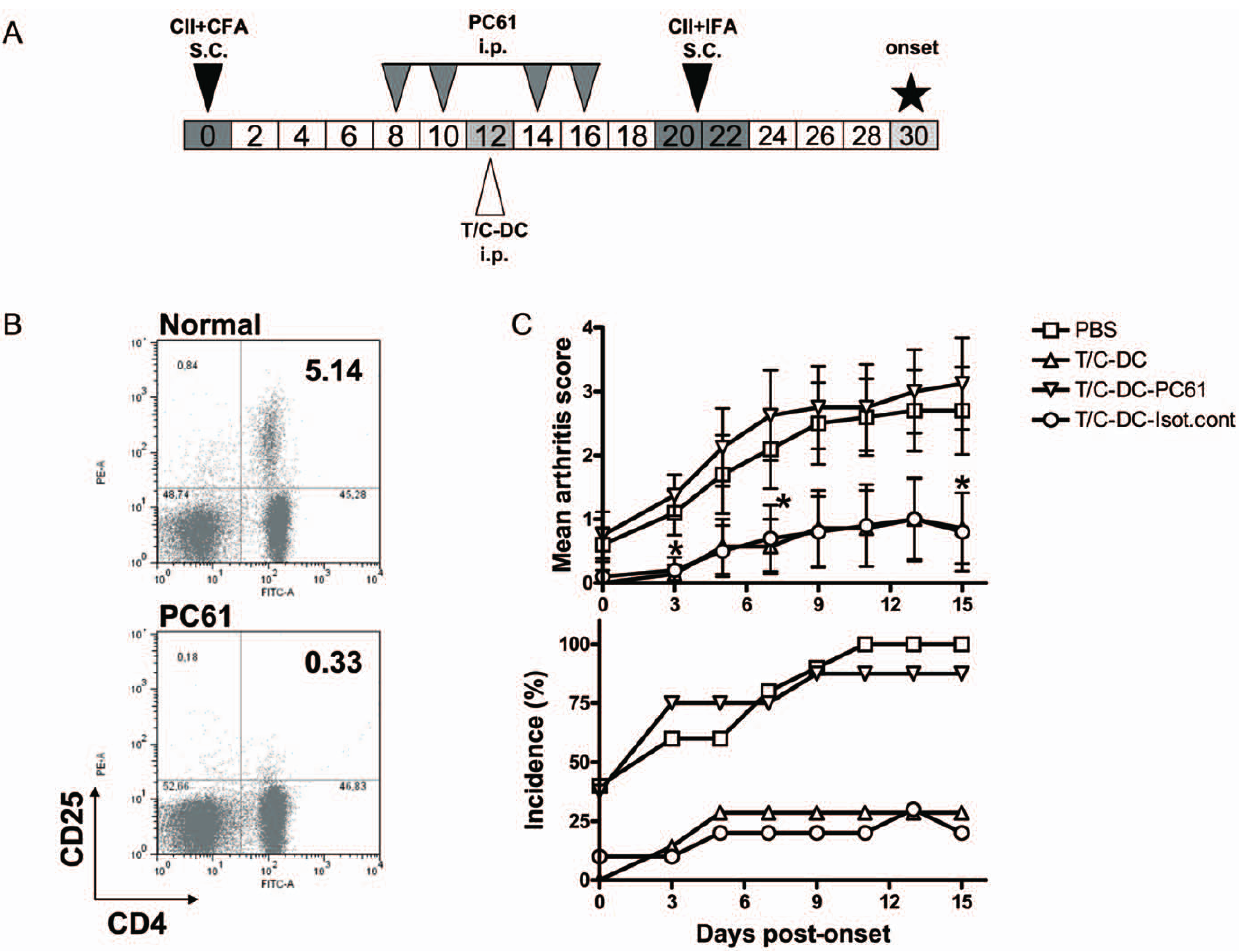
Figure 6. Depletion of CD25 + cells abrogated the ability of CII pulsed T/C-DC to inhibit the symptoms of CIA in mice. A) Mice were injected i.p. with four injections of 500 m g/mouse/day of anti-CD25 Ab (clone PC61) or the same amount of isotype control Ab (clone GL113), as shown in the scheme. B) Depletion of CD4 + CD25 + T cells was checked in DLN by FACS with anti-CD4 and anti-CD25 Abs (clone 7D4). A representative staining pattern is shown. C) Mice were injected with PBS; CII pulsed T/C-DC, CII pulsed T/C-DC plus the treatment with anti-CD25 Ab or CII pulsed T/ C-DC plus the treatment with anti-isotype control Ab. The arthritis score and incidence were assessed by clinical scoring during 15 days of onset. Values in arthritis score are the mean 6 SEM of 7–10 mice per group and the incidence shows data compiled from 3 independent experiments, * P , 0.05 for T/C-DC versus T/C-DC-PC61 on days 3, 7 and 15 of onset.